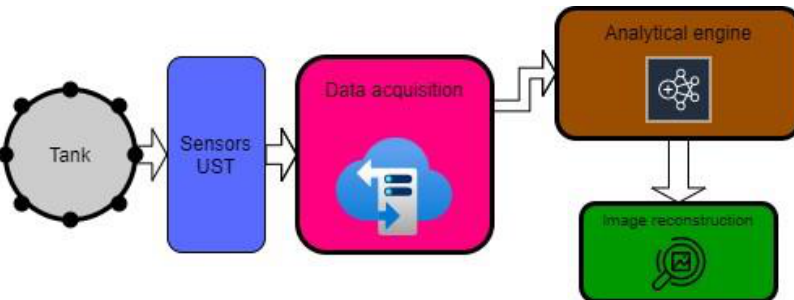
Figure 1. Schematic diagram of industrial process control with the use of ultrasound tomography.